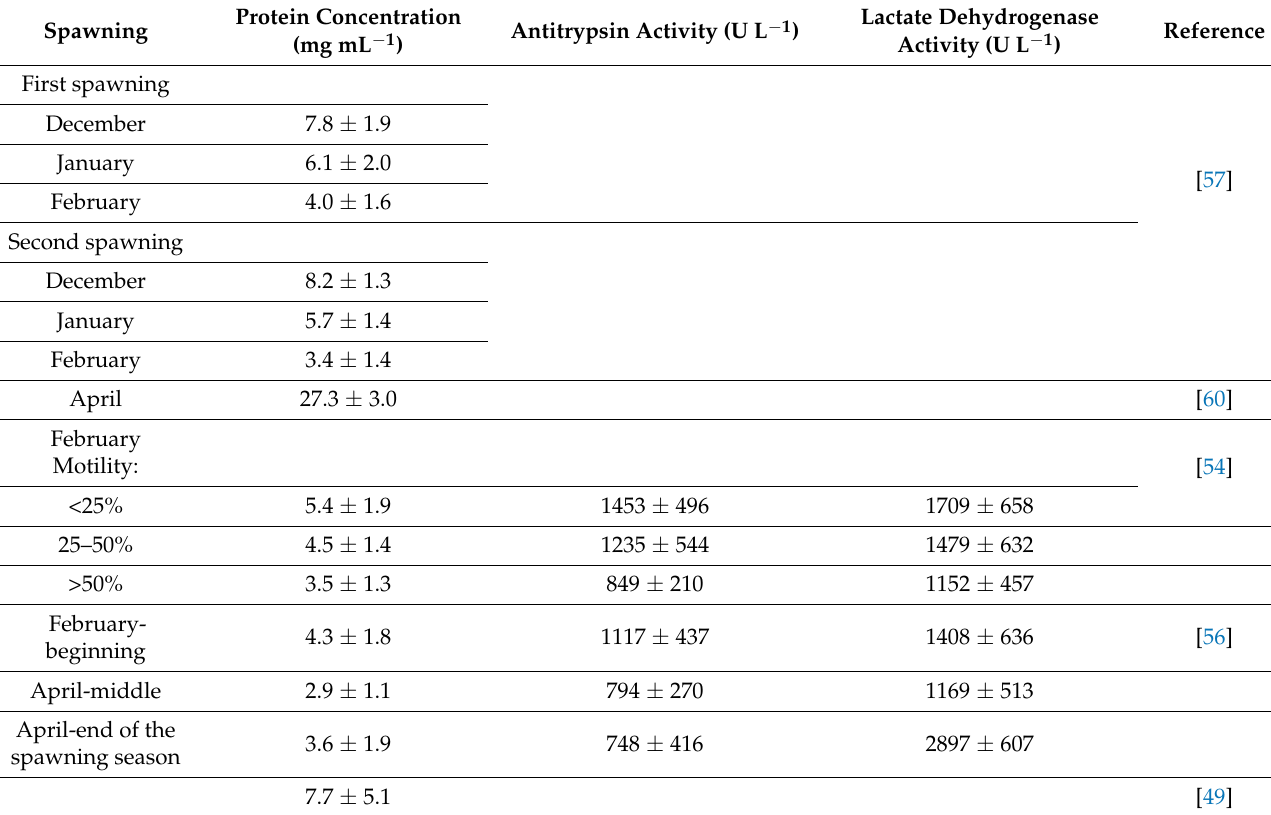
Table 4. Biochemical characteristics of the SRF rainbow trout ( Oncorhynchus mykiss